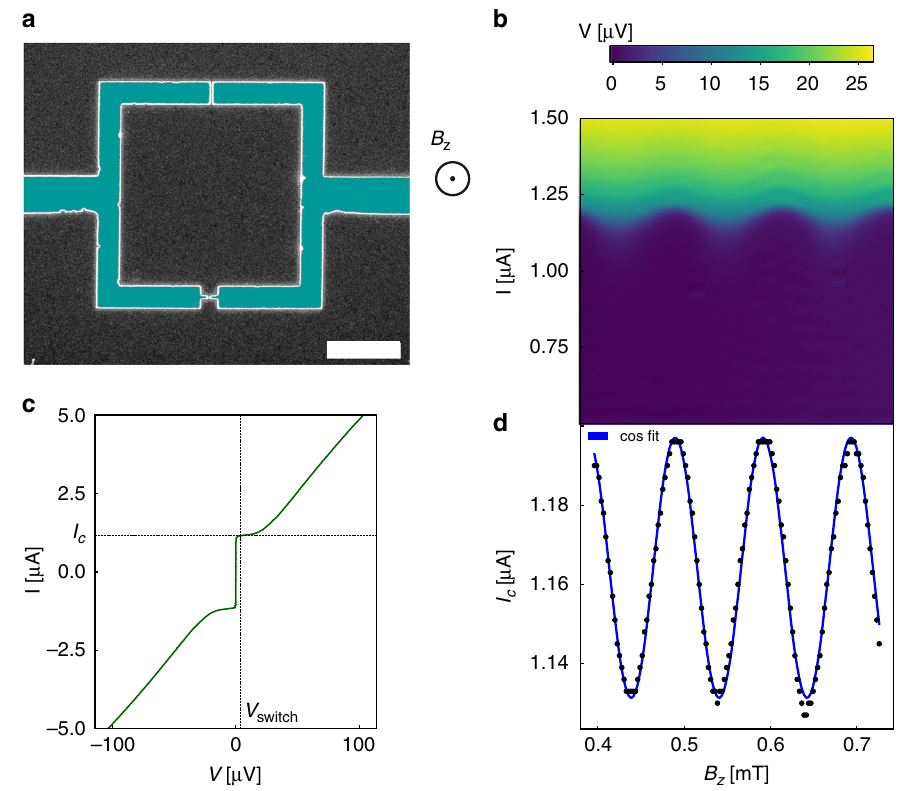
Fig. 1 Probing the CPR with a Josephson interferometer. a SEM image of a JI device. The scale bar is 2 μ m. This device consists of two Josephson junctions in parallel and enables probing the CPR of the smaller junction. The Aluminum electrodes are 50 nm thick. b Voltage map as a function of current and magnetic fi eld B z applied perpendicular to the fi lm plane showing zero voltage below a critical current value. The critical current of the small junction oscillates with the magnetic fl ux in the superconducting loop. c IV curve of the JI device. The critical current value I c is extracted when the junction develops a fi nite voltage de fi ned as B z and indicated by the dashed vertical line. d Critical current extracted from c as a function of B z . The oscillations are properly B ð Þ ¼ I þ I ð ω B Þ , indicating a sinusoidal CPR as expected for conventional Josephson described by the function I z z c c 1 c 2 cas